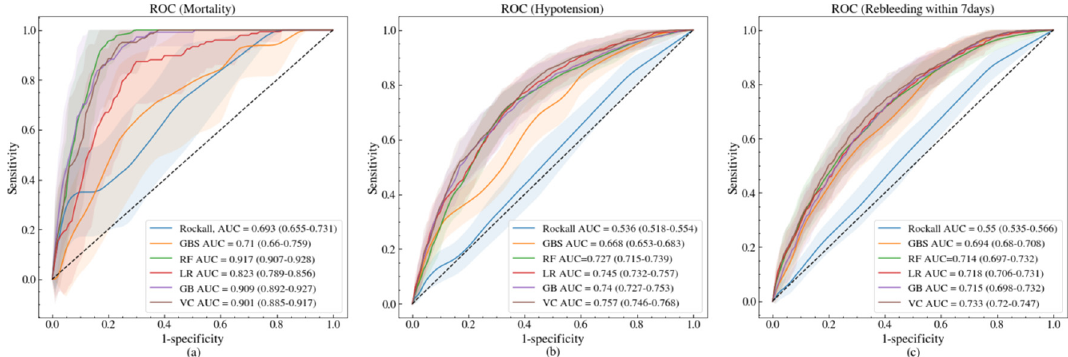
Figure 1. Receiver operating characteristic (ROC) and AUC of Rockall (blue), GBS (Glasgow–Blatchford score, orange), LR (logistic regression with regularization, red), RF (random forest classifier, green), GB (gradient boosting classifier, light purple), and VC (voting classifier, light brown) for mortality ( a ), hypotension ( b ), and rebleeding within 7 days ( c ), from left to right. The shaded regions stand for 1 standard deviation from the mean of the ROC curves. Mean AUC and its 95% confidence interval of the models are shown in the legends of the subplots.